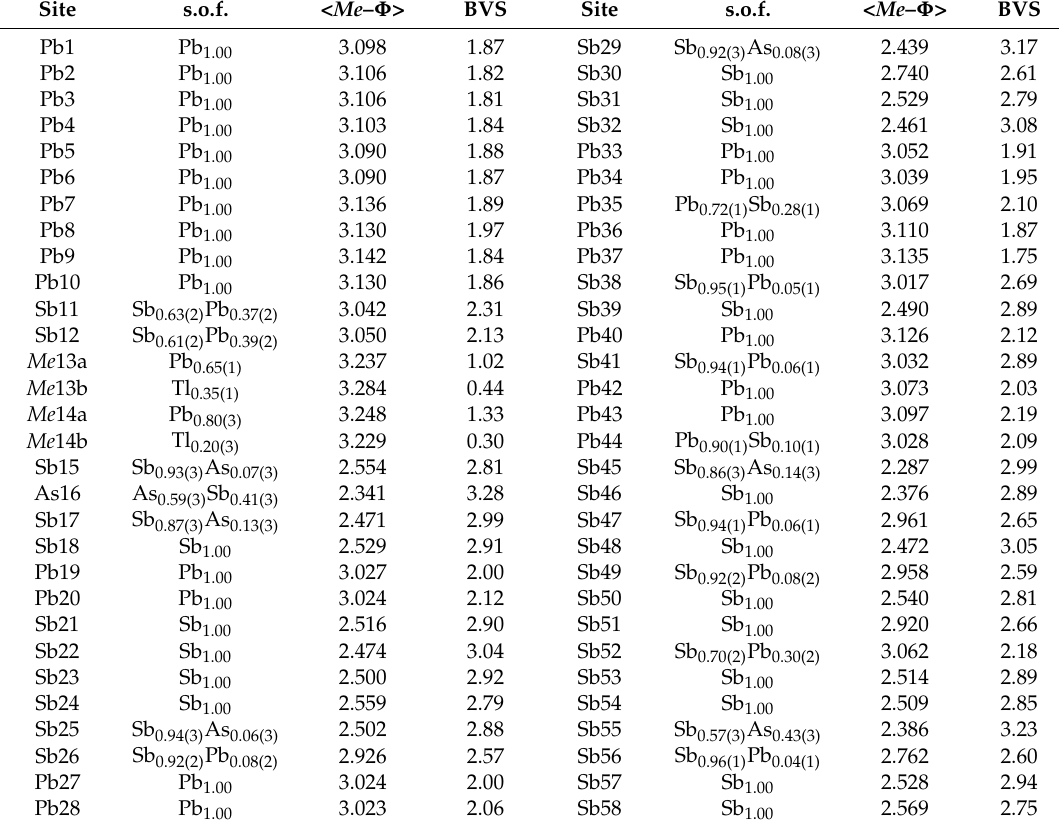
Table 2. Site occupancy factors (s.o.f.), average < Me – Φ > ( Φ = S, O) distances (in Å), and bond-valence sums (BVS) in valence units (v.u.) for cation positions.